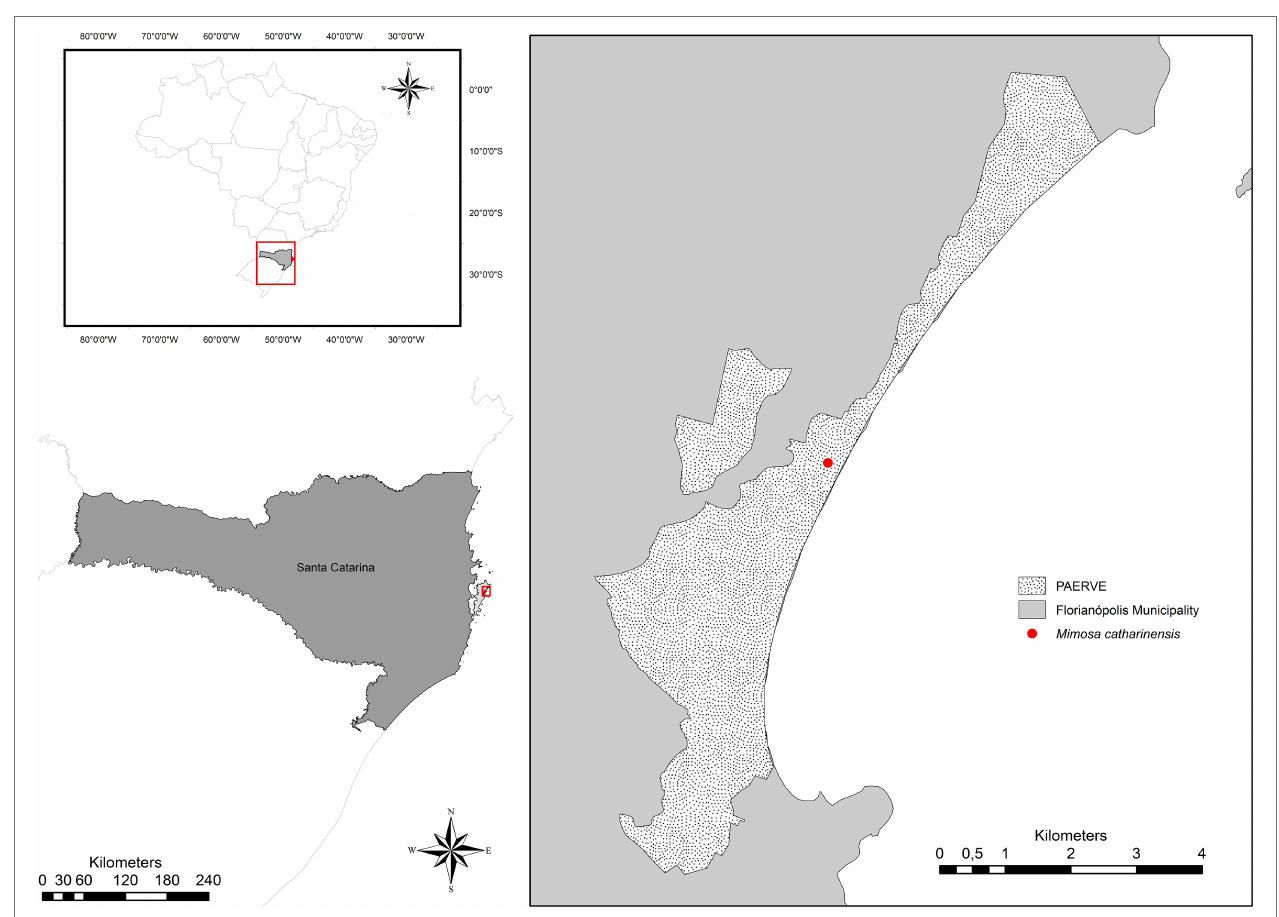
FIGURE 1 | Location of the extremely small and unique population of Mimosa catharinensis in Rio Vermelho State Park ( Parque Estadual do Rio Vermelho ; PAERVE), Santa Catarina State, Southern